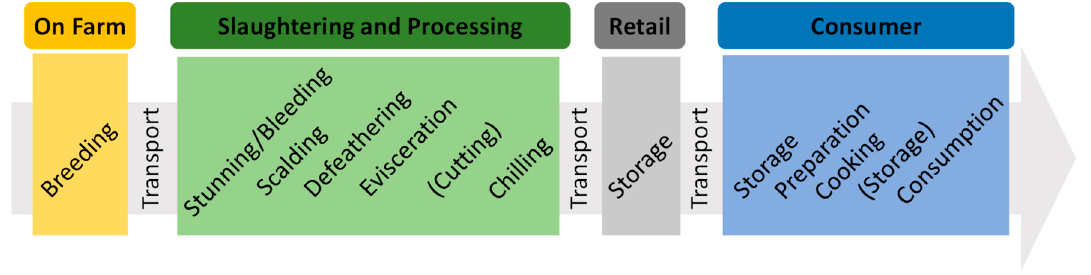
Figure 2. Farm-to-fork chain for poultry meat as commonly considered by quantitative microbial risk assessment (QMRA) studies. Steps within brackets are optional but considered by some authors.